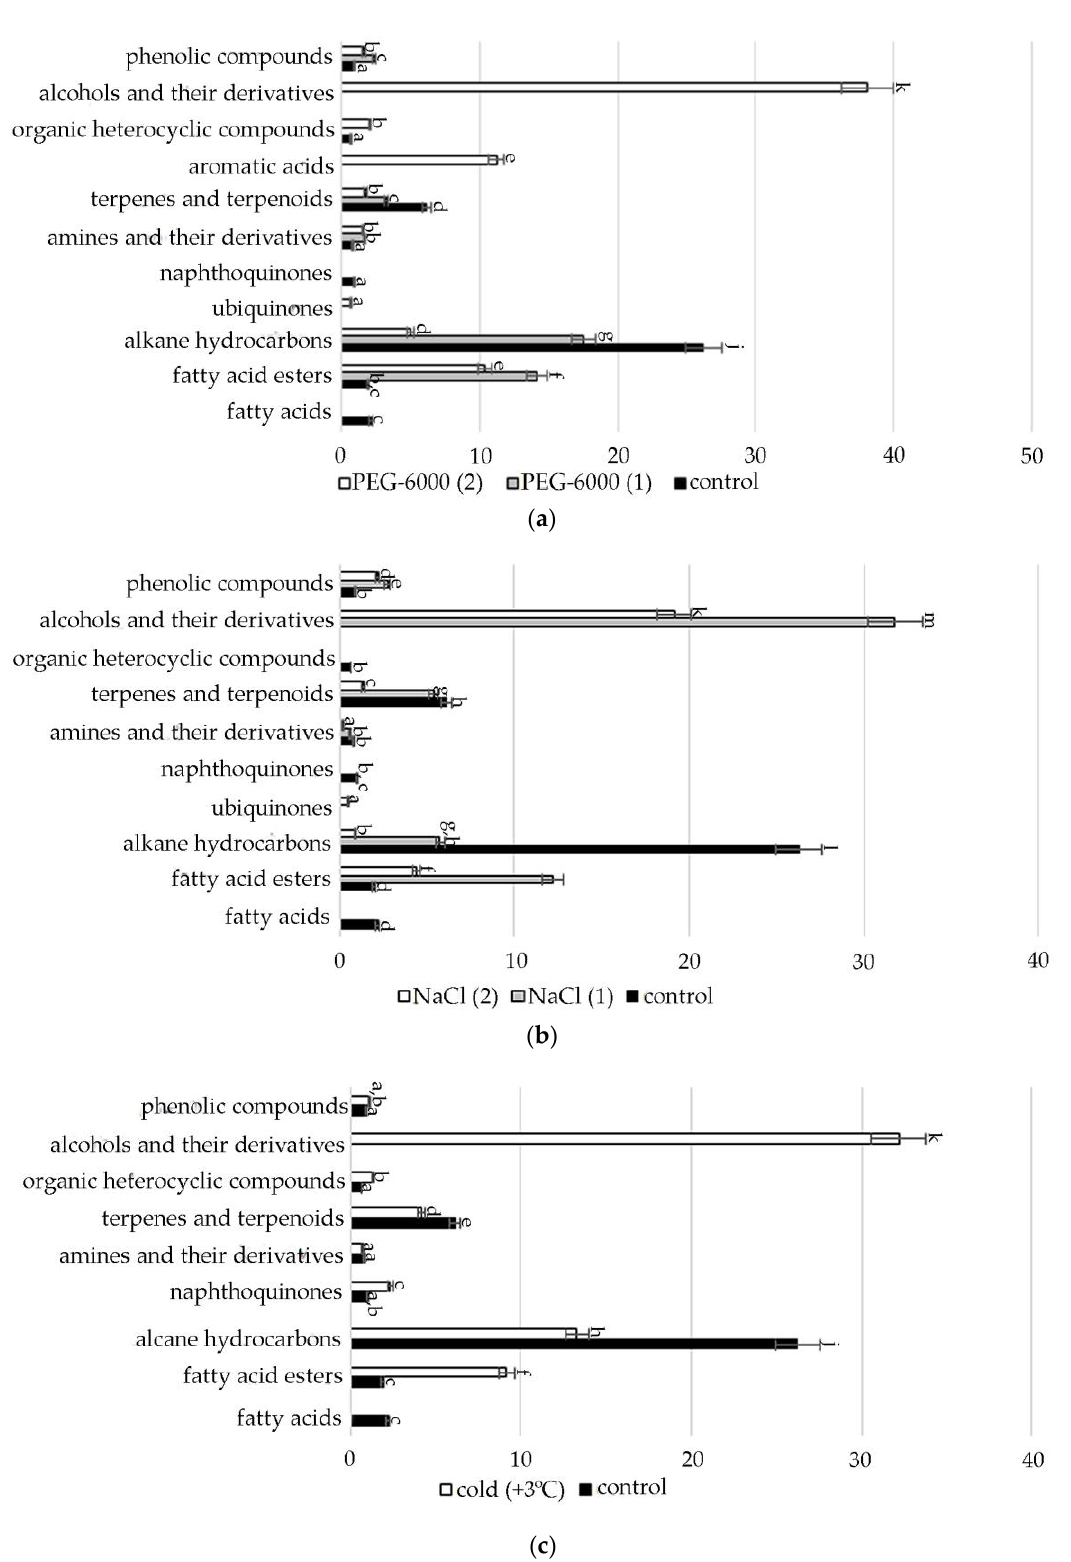
Figure 2. Change in content of secondary metabolite classes in S. hybridum under stress conditions: ( a ) osmotic stress; ( b ) salt stress; ( c ) cold stress. Values presented are means (±SD). Different letters above the bars represent significant differences at p ≤ 0.05, n = 3 plants in each of 3 replicates for all treatments.